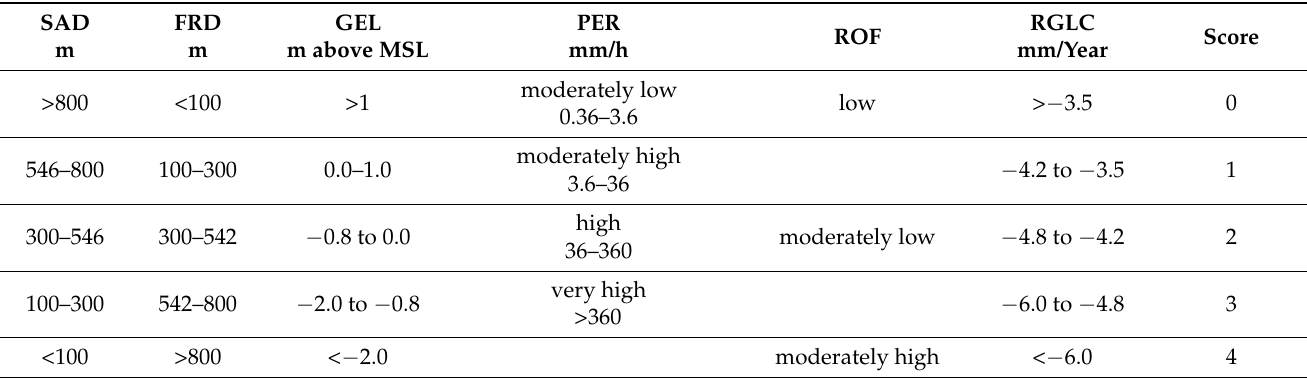
Table 2. Sensitivity-layer classification: ranges and scores. The values of 0 and 4 represent low and high contribution to vulnerability, respectively. Note that PER ranking is increased of one score point in correspondence to geomorphological structures.